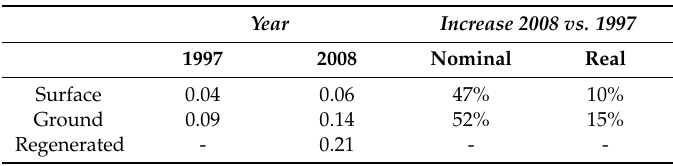
Table 2. Average water cost by source (EUR/m 3